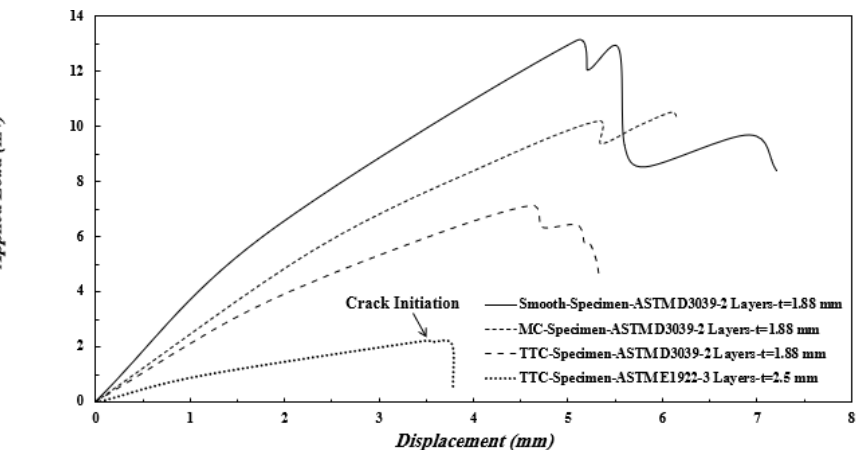
Figure 12. Load-Displacement diagram for ASTM E1922 and ASTM D3039 specimens.